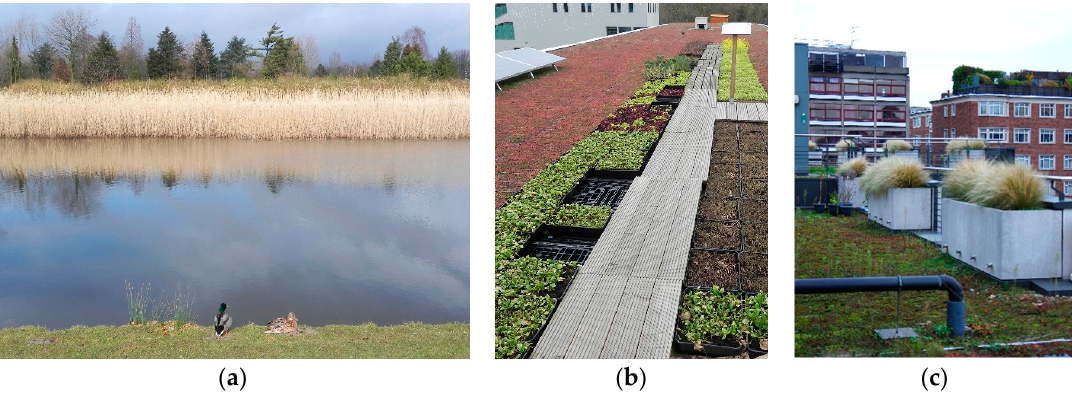
Figure 5. ( a ) Blue-green infrastructures in Rotterdam (photo by Misagh Mottaghi); ( b ) Amsterdam (photo by Misagh Mottaghi); and ( c ) London (photo by Johanna